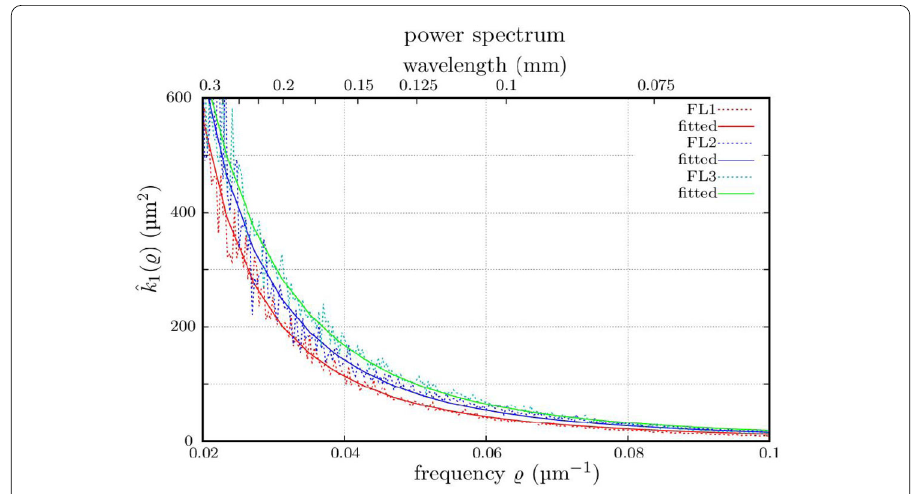
Figure 14 Estimates of the power spectrum of the nonwovens FL1, FL2, and FL3 from the images in Figs. 7a, 11a and 11b, respectively, and the function from (7) fitted to the estimated power spectra. Linear scale